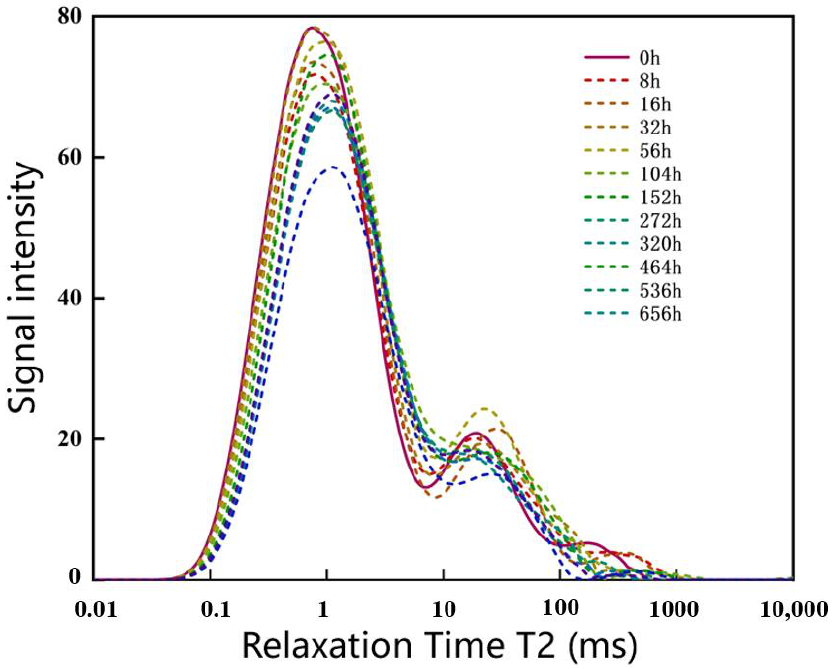
Figure 7. Development of T 2 of sample XBL at 1 atm.